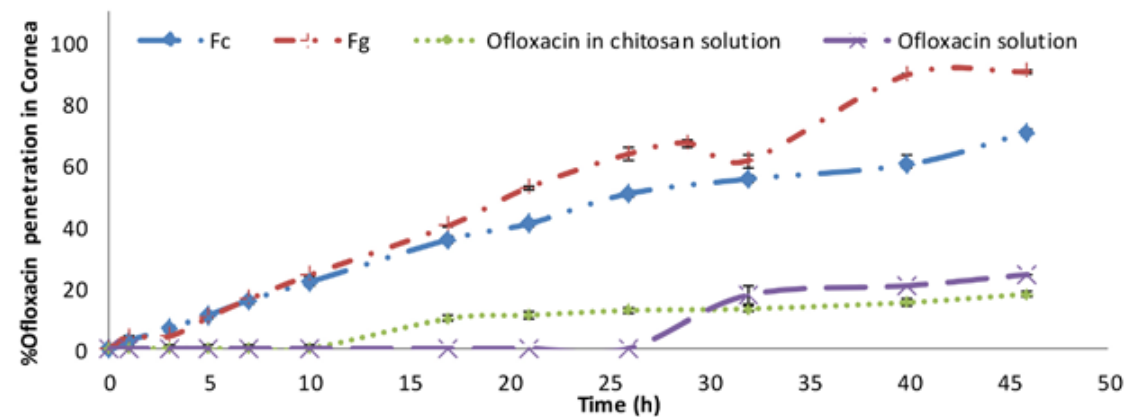
FIGURE 7 - In situe penetration profile of ofloxacin from Chitosan/TPP nanoparticles (Fc); Chitosan/TPP-Alginate nanoparticles (Fg); ofloxacin in chitosan solution; ofloxacin solution. Penetration assay was performed in PBS solution, pH: 7.4, at 37°C with agitation (n=3). TABLE III - Permeability coefficients and lag time Formulation